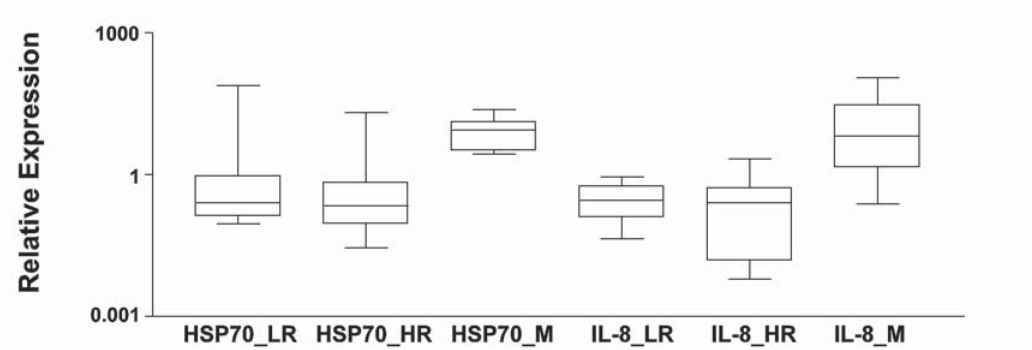
Figure 3 – Box-and-whisker plots of HSP70 and IL-8 expression in low-risk (LR), high-risk (HR) and metastatic (M) renal cell